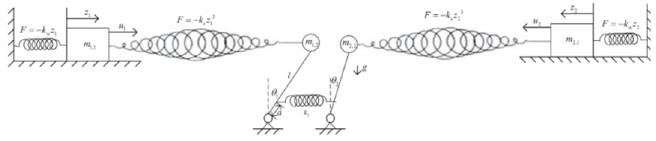
Figure 2. Coupled underactuated mechanical systems.